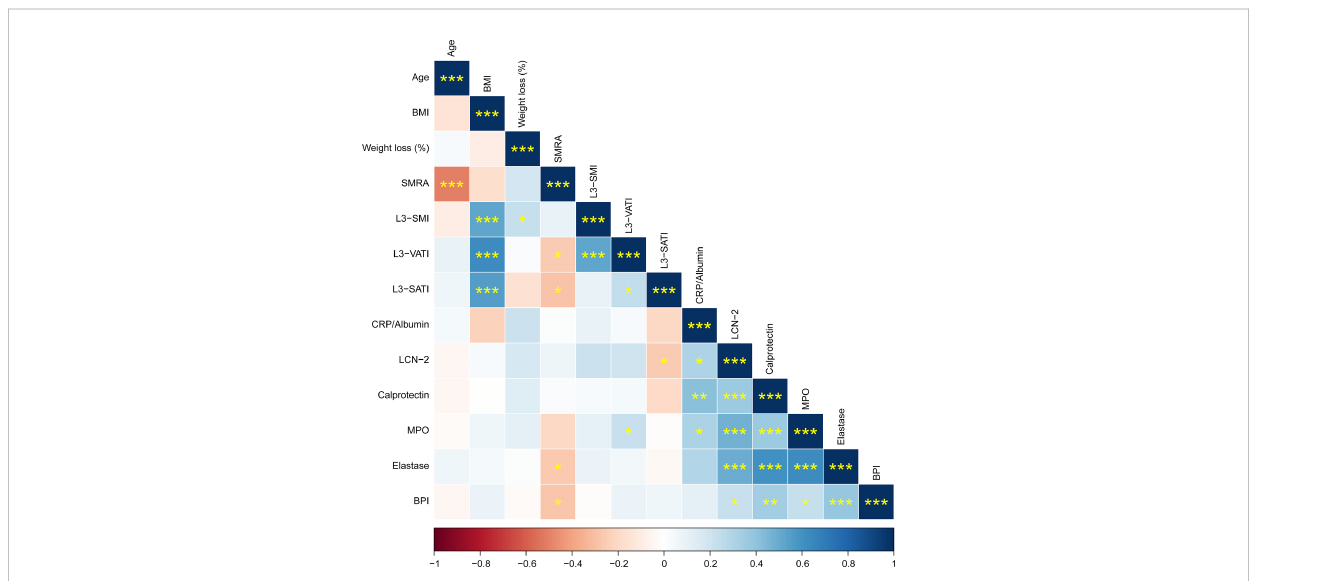
FIGURE 1 Correlation matrix showing Spearman correlations between patient characteristics and circulating factors. Positive correlations are shown in blue, negative correlations in red. The color intensity indicates the Spearman ’ s correlation coef fi cient (bottom legend). The asterisks indicate the level of statistical signi fi cance (* p < 0.05, ** p < 0.01, *** p <